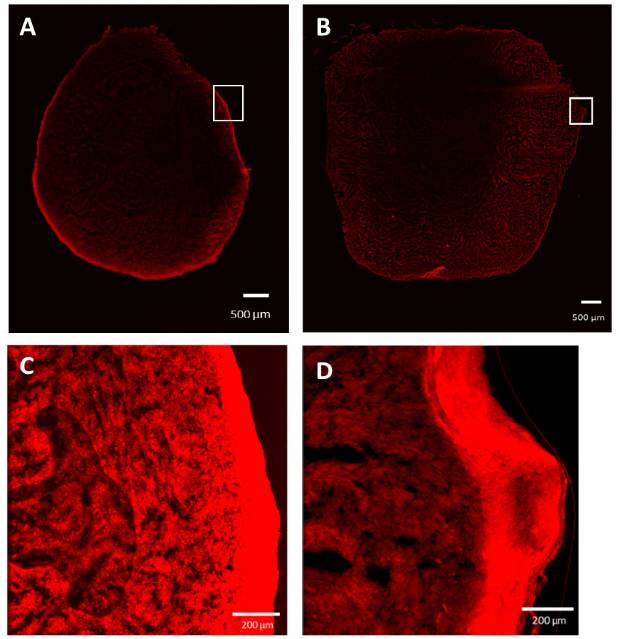
Figure 5. Confocal imaging of an ectopic tumor at 24 h after the administration of compound 24 ( A , C ) or compound 25 ( B , D ). Scale bars are represented.